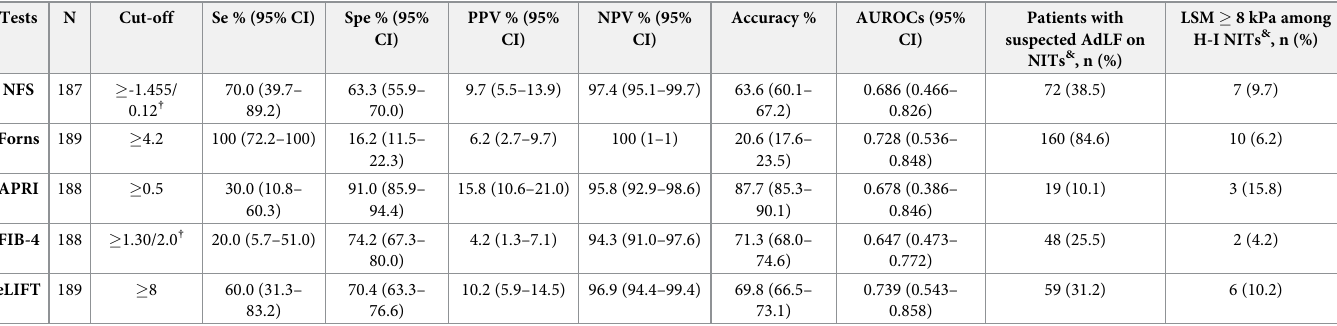
Table 3. Screening for advanced liver fibrosis (LSM � 8.0 kPa) using non-invasive fibrosis tests in patients with a valid Fibroscan.